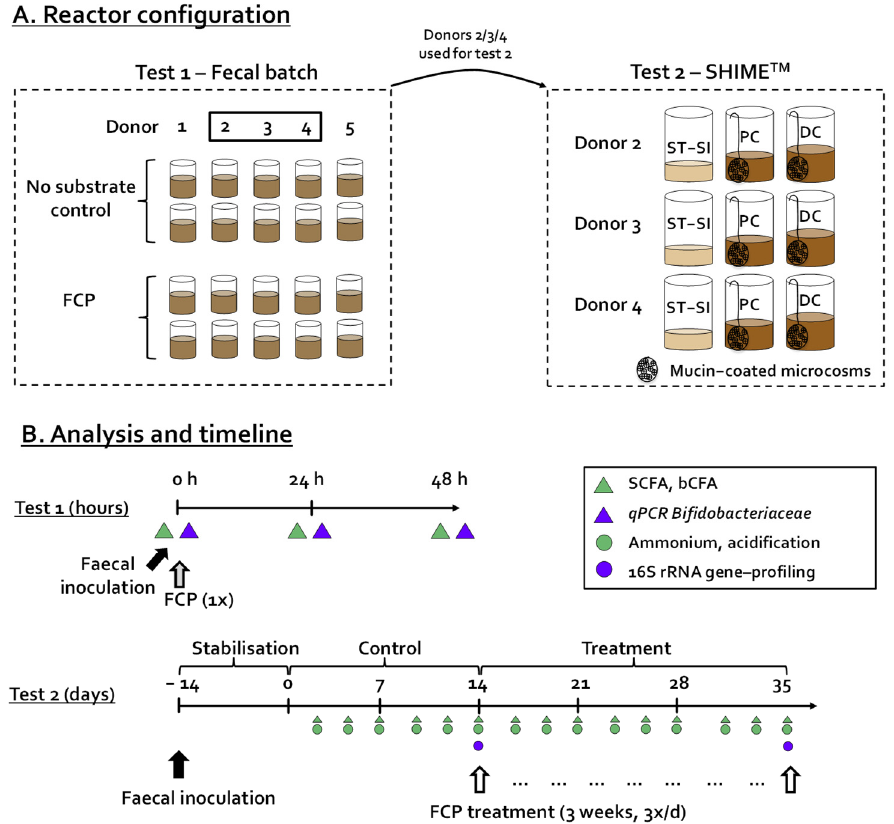
Figure 1. ( A ) Reactor configuration and ( B ) timeline of the in vitro experiments (test 1 and test 2) during which the impact of a freeze-dried cranberry powder (FCP) was assessed on the activity and composition of the simulated human colonic microbiota. SHIME, Simulator of the Human Intestinal Microbial Ecosystem; ST-SI, stomach–small intestine; PC, proximal colon; DC, distal colon; bCFA, branched-chain fatty acids; SCFA, short-chain fatty acids.